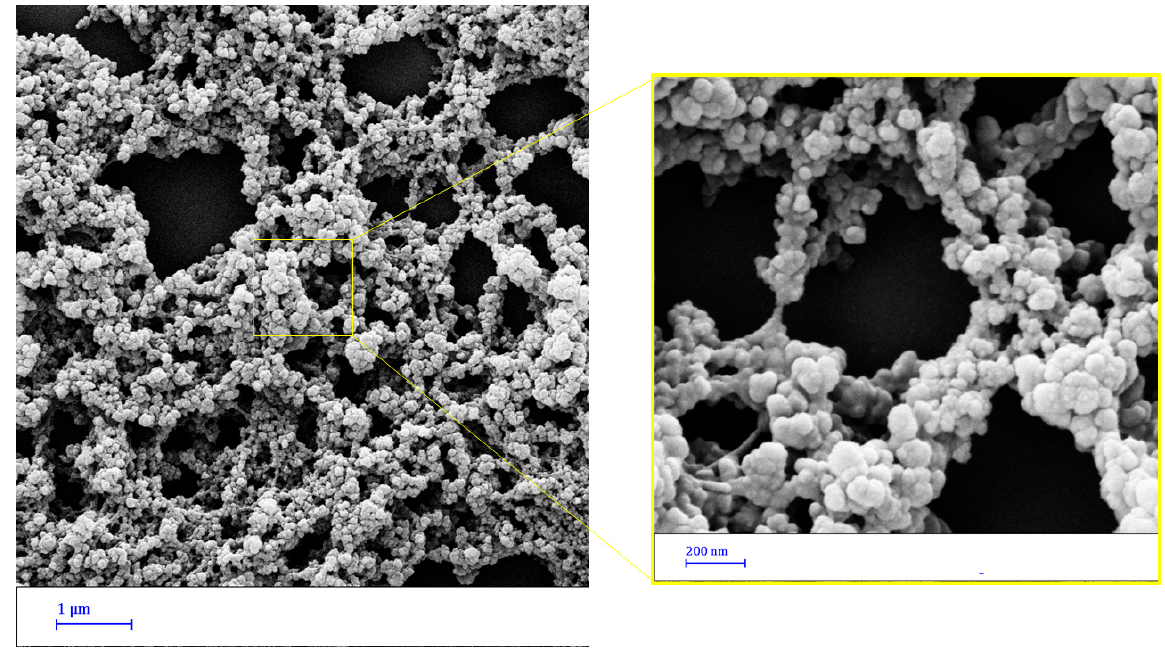
Figure 4. FESEM micrographs of freeze-dried core-shell microgel.